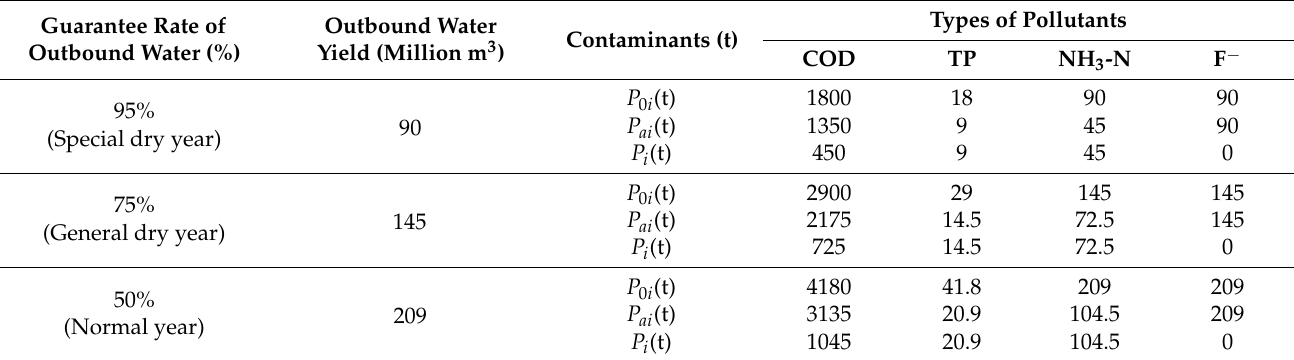
Table 4. Transboundary volume and reduction of pollutants exceeding the standard in the Bahao Bridge section under the target scenario.